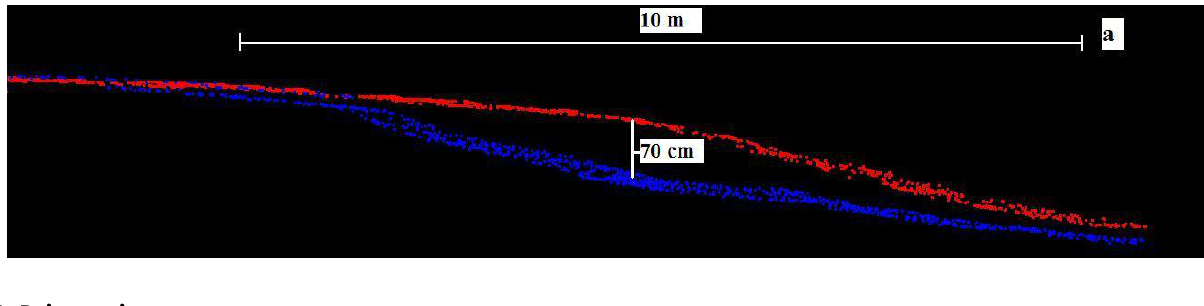
Figure 8. Cross-section of deposition effects on Point Bar 2. Blue represents data in 2008 and red data in